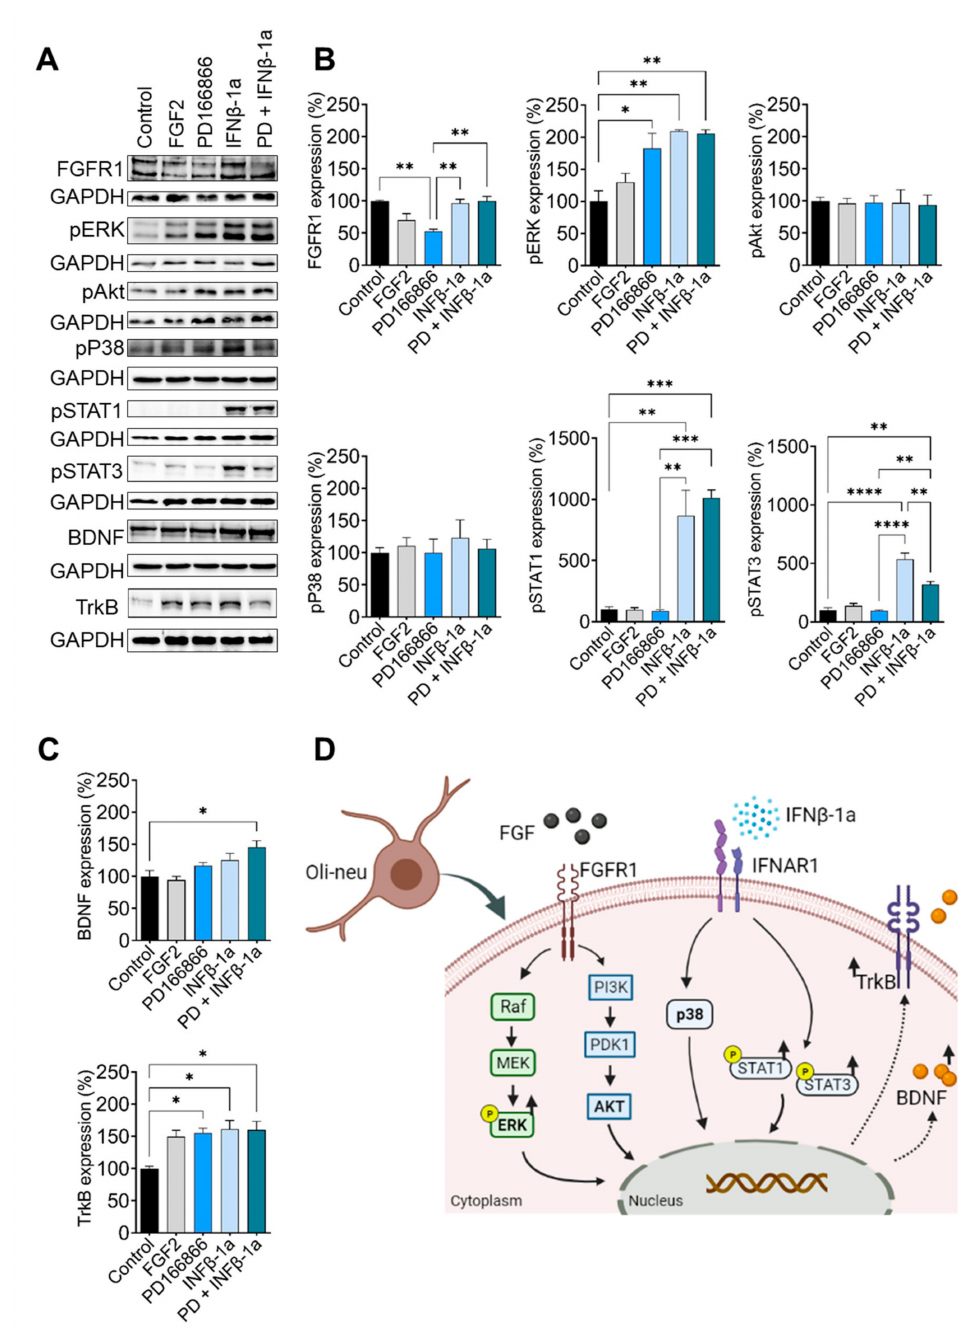
Figure 4. Effect of IFN β -1a and FGFR1 inhibition by PD166866 in FGFR downstream signaling proteins in oligodendrocytes in vitro. Oli-neu oligodendrocyte cells were incubated with culture medium containing FGF2 (20 ng/mL), PD166866 (10 µ M), IFN β -1a (400 ng/mL, Rabiff), IFN β -1a + PD166866. ( A , B ) FGFR1 protein expression was significantly lower in cells treated with PD166866 compared to controls. Protein expression of pERK, BDNF ( C ; PD with IFN) and TrkB were increased after PD166866, IFN β -1a, and PD166866 with IFN β -1a. Increased phosphorylation of STAT1 and 3 were found in cells treated with PD166866 as well as PD166866 with IFN β -1a. ( D ) Overview of the effect of IFN β -1a and FGFR1 inhibition by PD166866 in FGFR downstream signaling proteins in oligodendrocytes. Data are presented as mean ± SEM from three independent experiments, * p < 0.05, ** p < 0.01, *** p < 0.001, **** p <